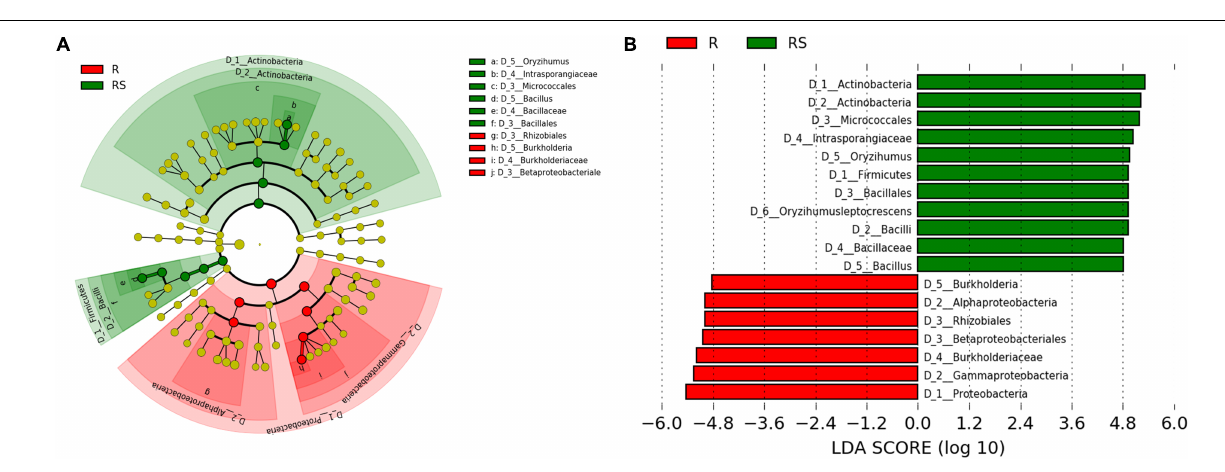
FIGURE 2 | Comparison of bacteria between the rhizosphere and root compartments. (A) Phylogenetic dendrogram of biomarkers in the R and RS sugarcane groups. Circles from inside to outside indicate bacterial taxonomic levels from phylum to genus. Yellow dots represent bacteria not significantly varying in abundance among treatments. Biomarker bacteria are colored according to their corresponding class colors on the right. (B) LDA scores of biomarker bacteria for each combination of sugarcane sites. LDA scores are shown as horizontal bars for the biomarker bacteria with an LDA score > 4.8 as listed on the left, Kruskal–Wallis rank sum test, P < 0.05. LDA, linear discriminant